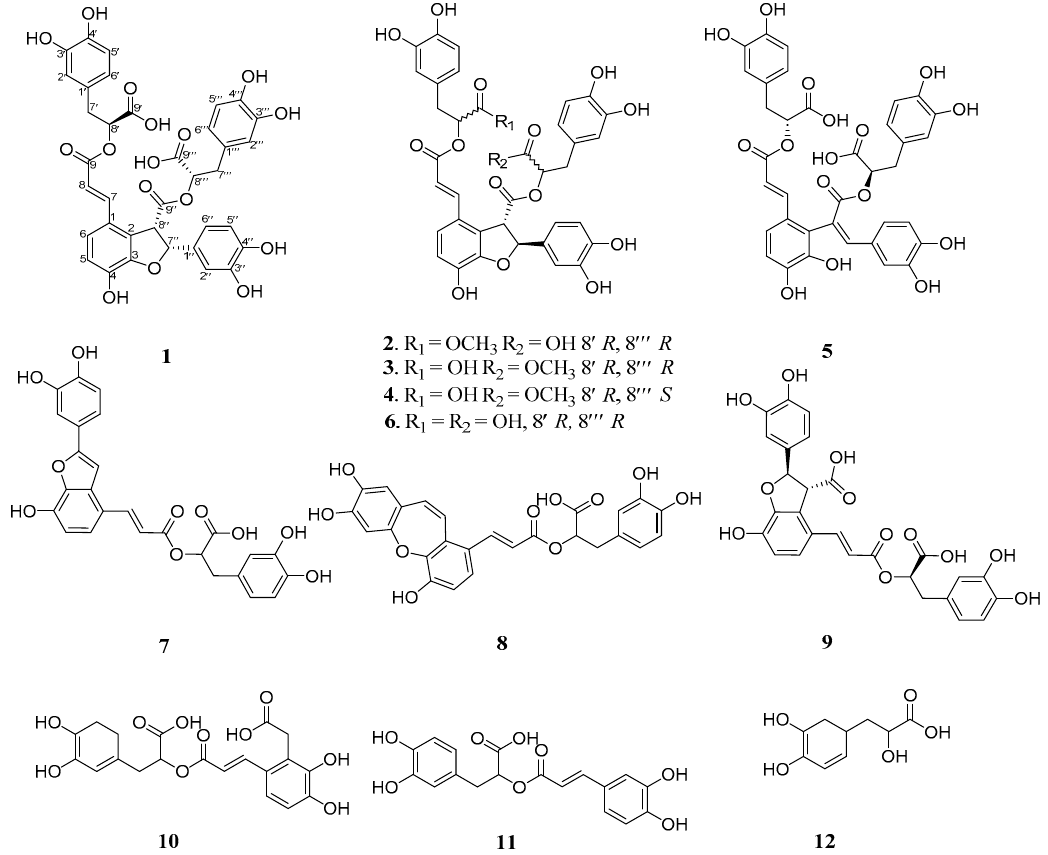
Figure 1. Chemical structures of compounds 1 – 12 from roots of S. miltiorrhiza Figure 1 . Chemical structures of compounds 1 – 12 from roots of S. miltiorrhiza .